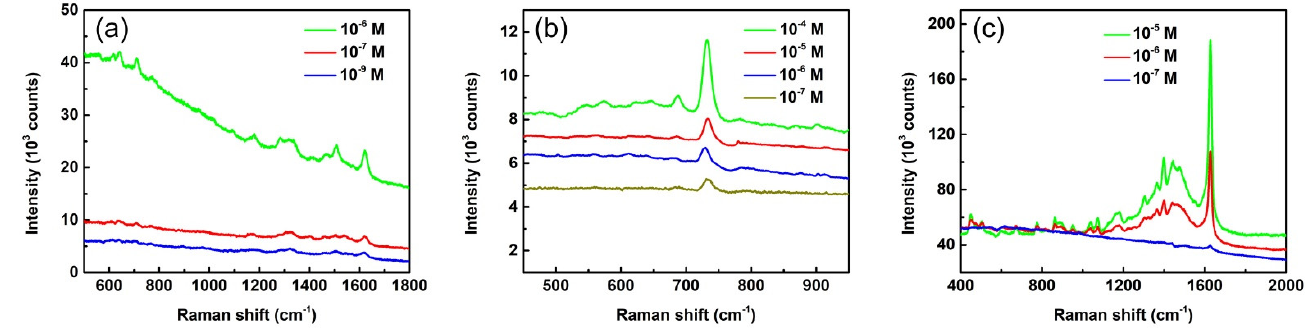
Figure 7. SERS spectra of ( a ) eosin Y, ( b ) adenine, and ( c ) methylene blue with different concentrations. The spectra are pristine with neither intensity shift nor background subtraction. The laser wavelength of 532 nm and lens of 50× were used for the measurement. The exposure times are 1 s for ( a ), 3 s for ( b ), and 10 s for ( c ).